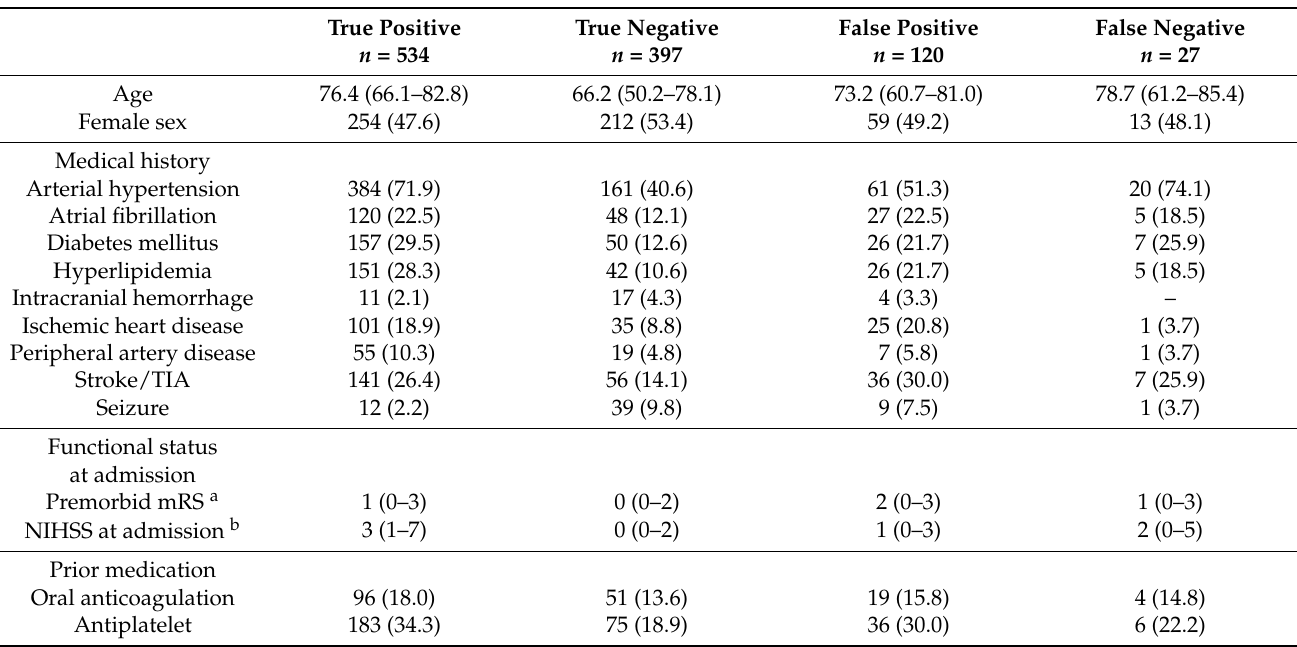
Table 1. Patient characteristics categorized according to correctness of teleneurological diagnosis of cerebrovascular disease based on n = 1078 consultations.